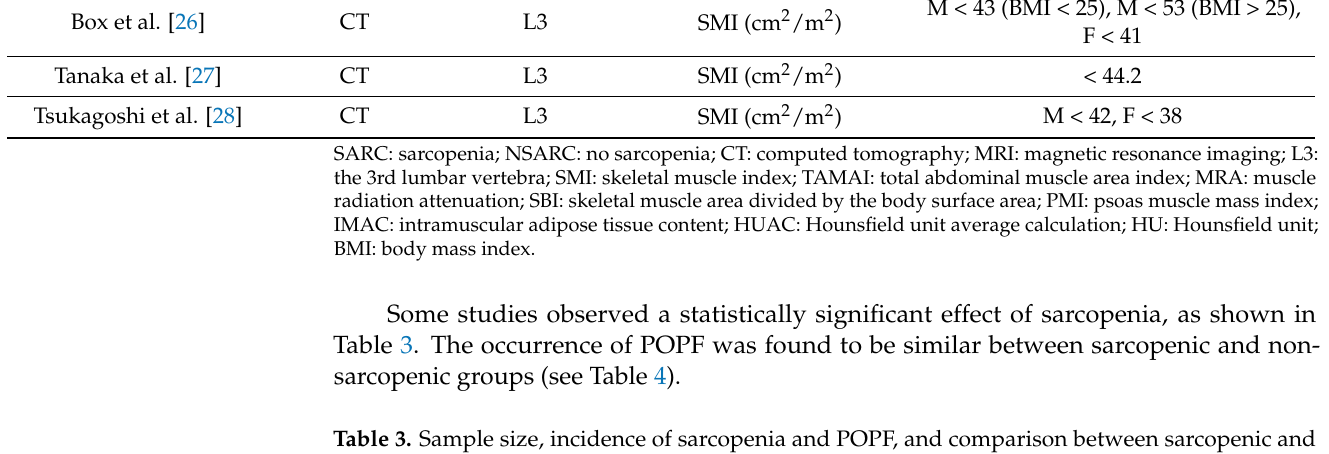
Table 3. Sample size, incidence of sarcopenia and POPF, and comparison between sarcopenic and non-sarcopenic